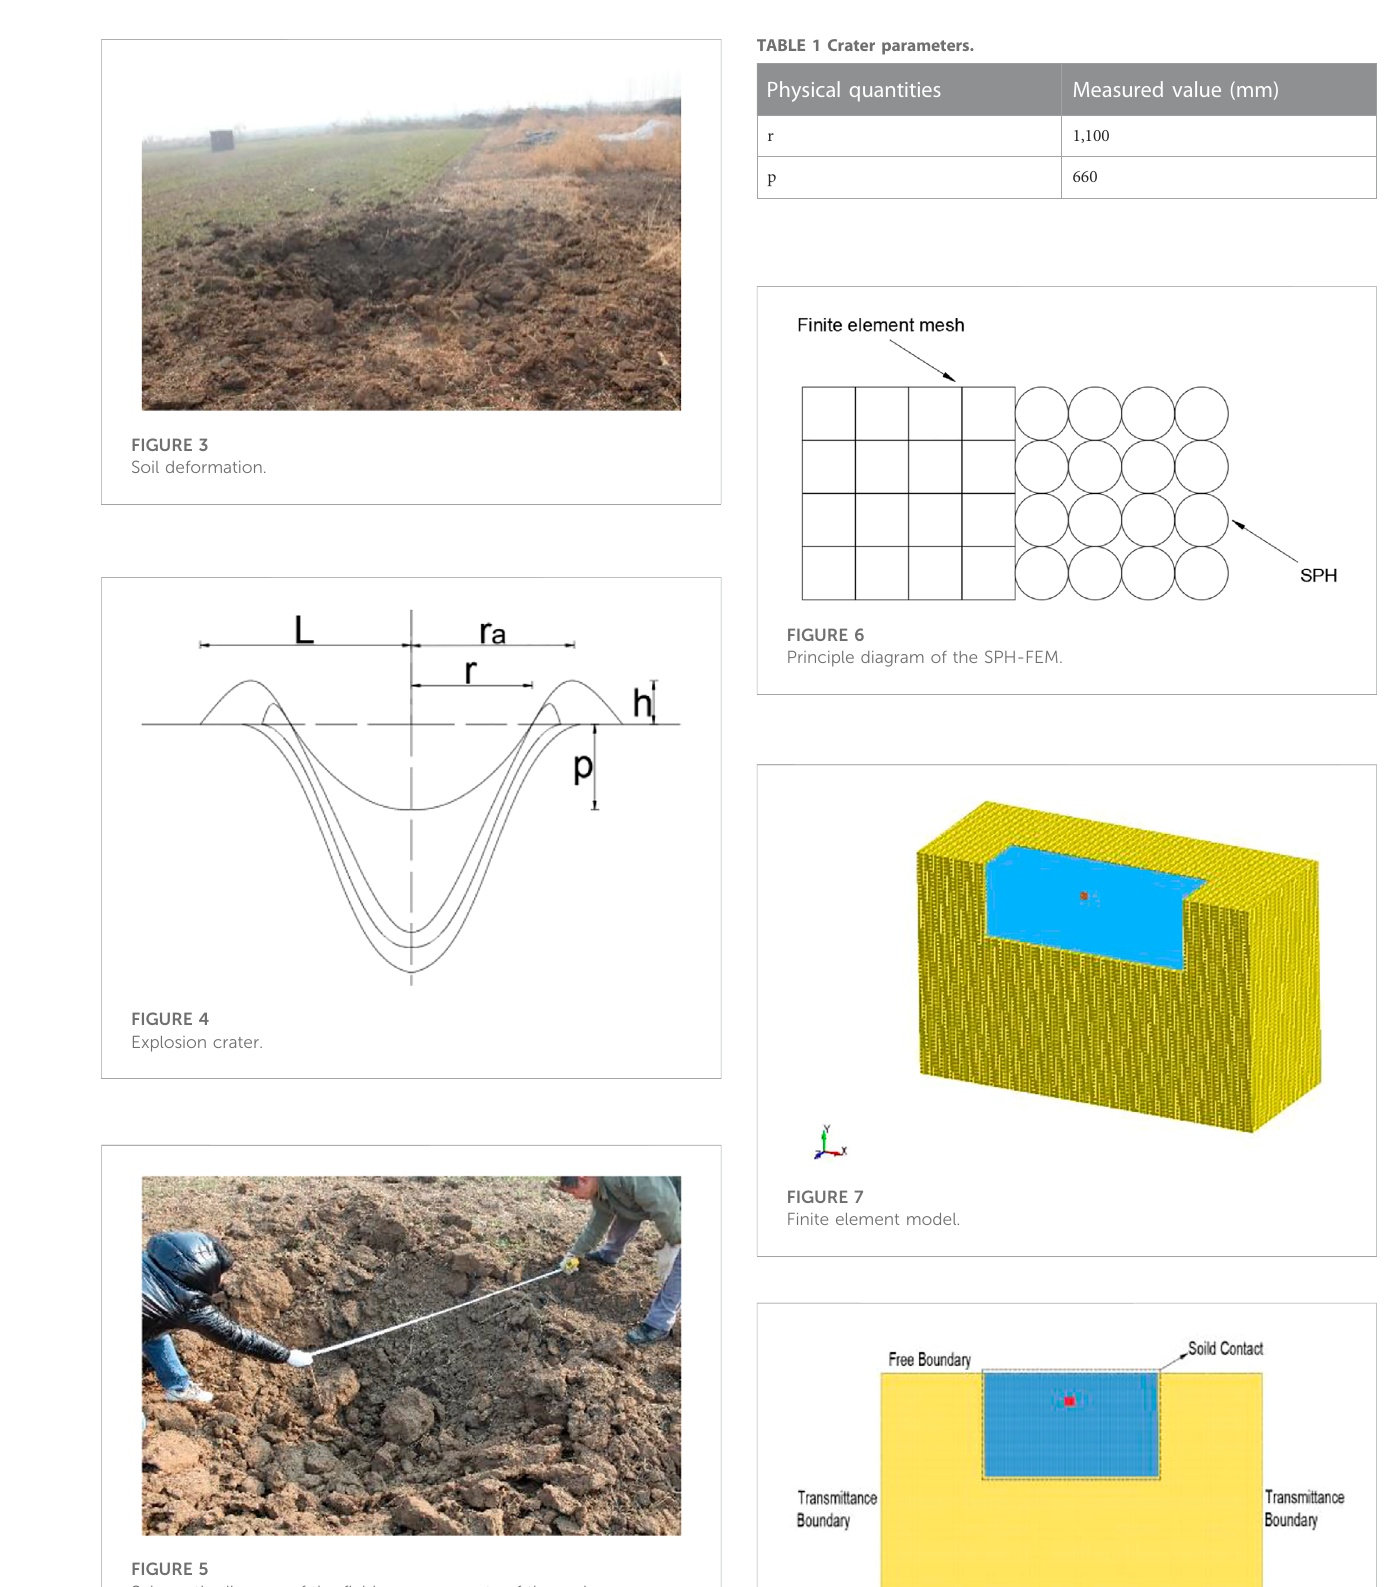
Schematic diagram of the fi eld measurements of the main